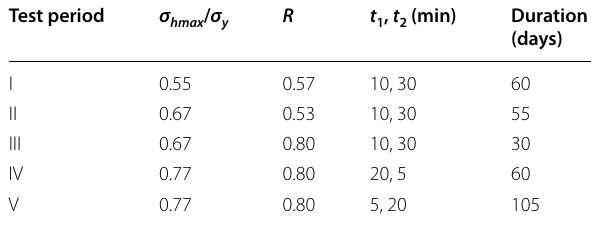
Table 3 Information on the test periods for